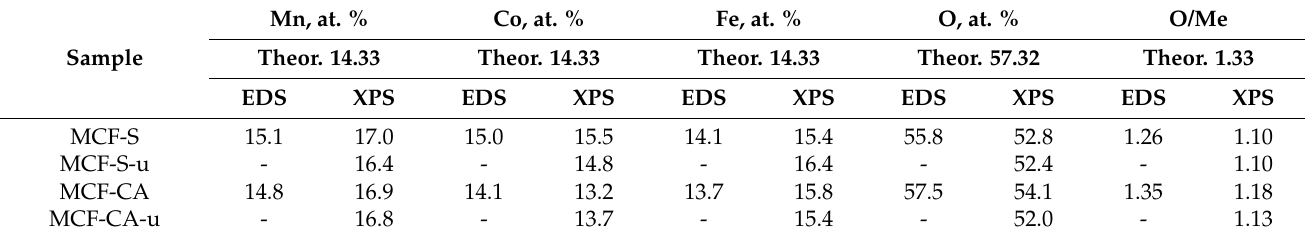
Table 3. Bulk (EDS) and surface (XPS) chemical compositions of the samples.